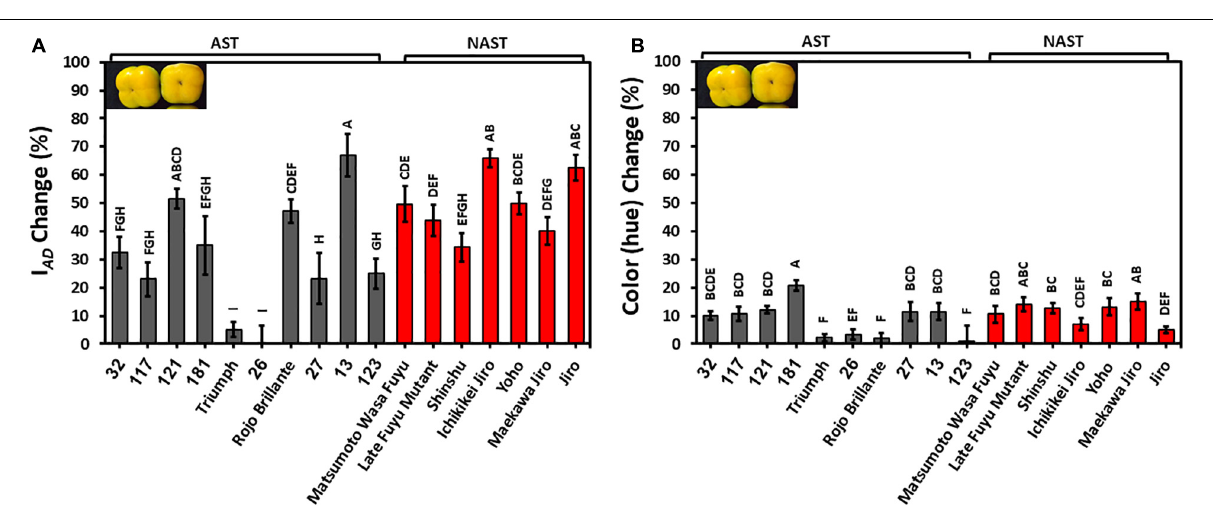
FIGURE 5 | Reduction in chlorophyll (I AD ) and color (hue) in persimmon cultivars after 3 months of storage for harvest 2019. (A) Change in I AD ; (B) Change in hue. Bars show the average of 10 fruits in 4 places; ± SE. Different letters indicate a significant difference between treatments according to the Tukey-Kramer HSD test at p ≤